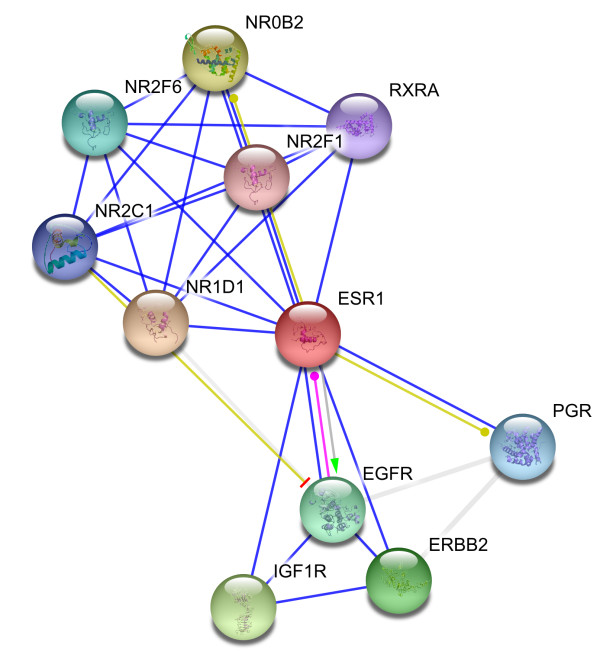
Hubs of NR-RTK network previously inferred in [10].